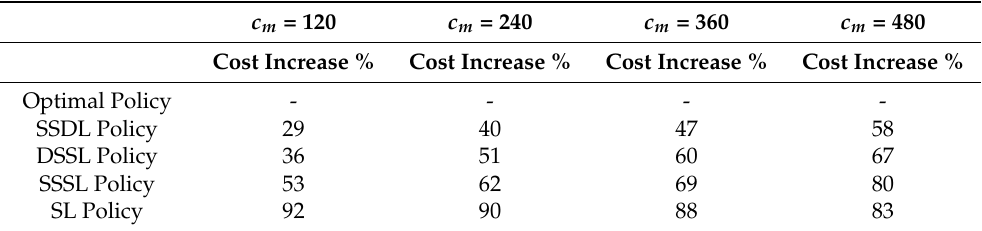
Table 3. Comparison of different policies with varying mission failure